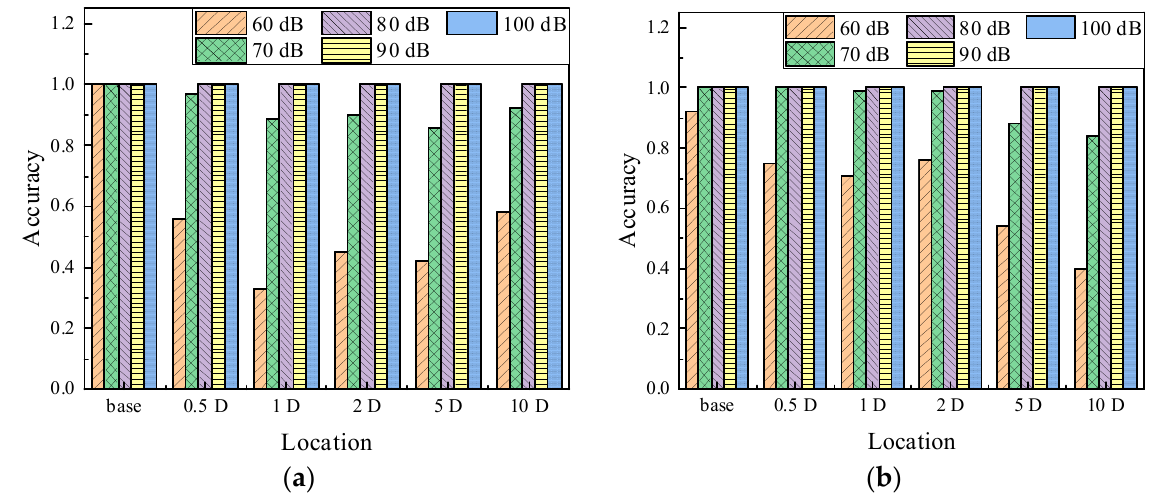
Figure 22. Locations identification in pipeline. ( a ) Location detects without welding defect. ( b ) Location detects with welding defect